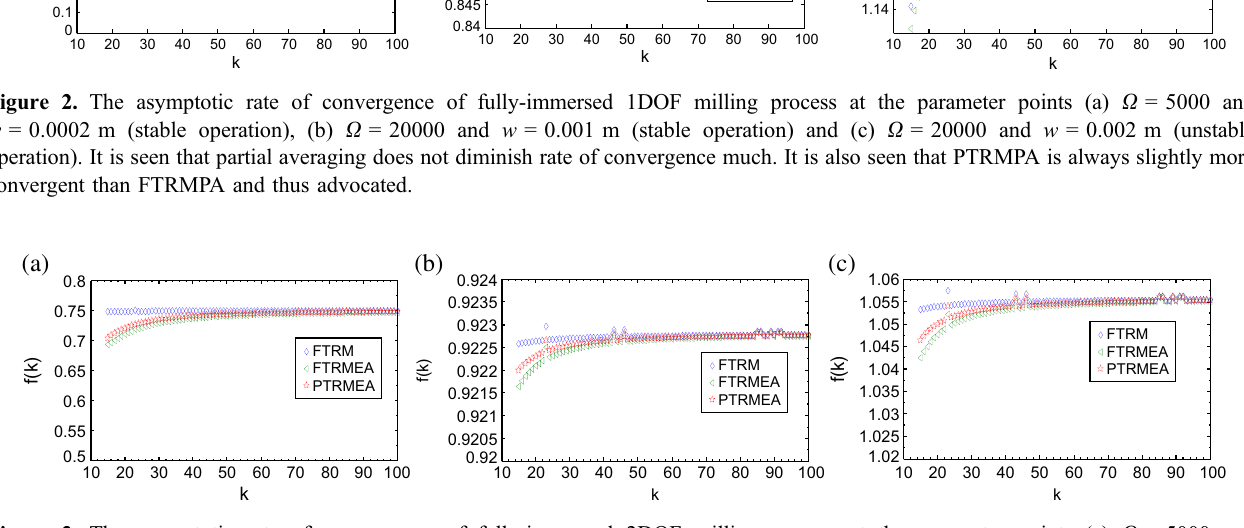
Figure 3. The asymptotic rate of convergence of fully-immersed 2DOF milling process at the parameter points (a) X = 5000 and w = 0.00001 m (stable operation), (b) X = 20,000 and w = 0.00001 m (stable operation) and (c) X = 20,000 and w = 0.0001 m (unstable operation). It is seen that partial averaging does not diminish rate of convergence much. It is also seen that PTRMPA is always slightly more convergent than FTRMPA and thus